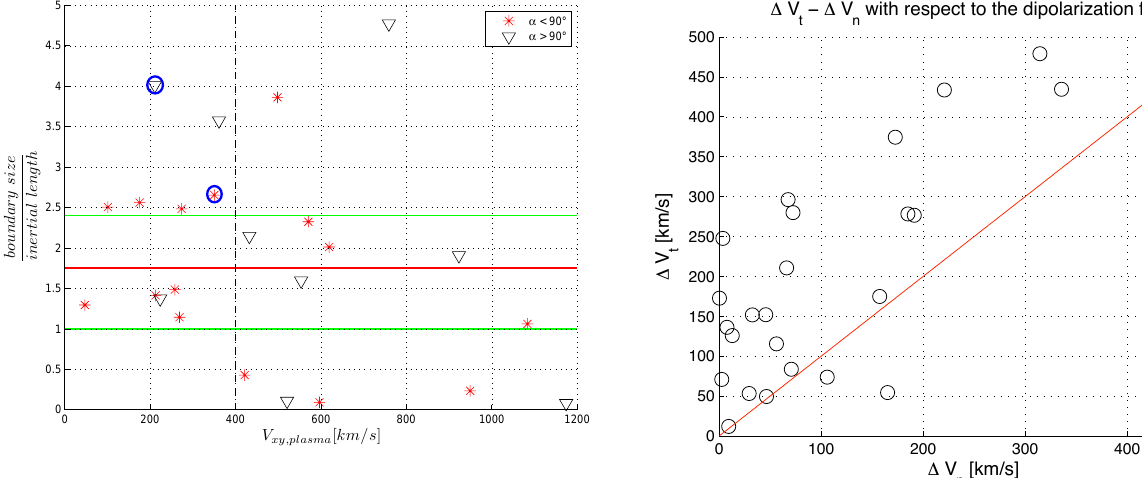
Fig. 6. Ratio of the estimated boundary size of the magnetic struc- ture and the inertial length of the protons in the magnetic structure for the evaluated 24 events. α is the angle between the estimated normal velocity of the magnetic structure and the maximum per- pendicular plasma flow in XY plane. The 15 dipolarization events with an angle α < 90 ◦ are marked by stars. The 9 dipolarization events with an angle α > 90 ◦ are marked by triangles. The vertical doted line indicate the 2 velocity bins. The horizontal line is the median of the ratio boundary size and inertial length of the 24 dipo- larization events and is about ∼ 1.8. The horizontal green lines are the upper and lower quartiles of the median. The event from 8 Au- gust 2003 is the star, marked by a circle. The event from 1 October 2003 is the triangle, marked by a circle.